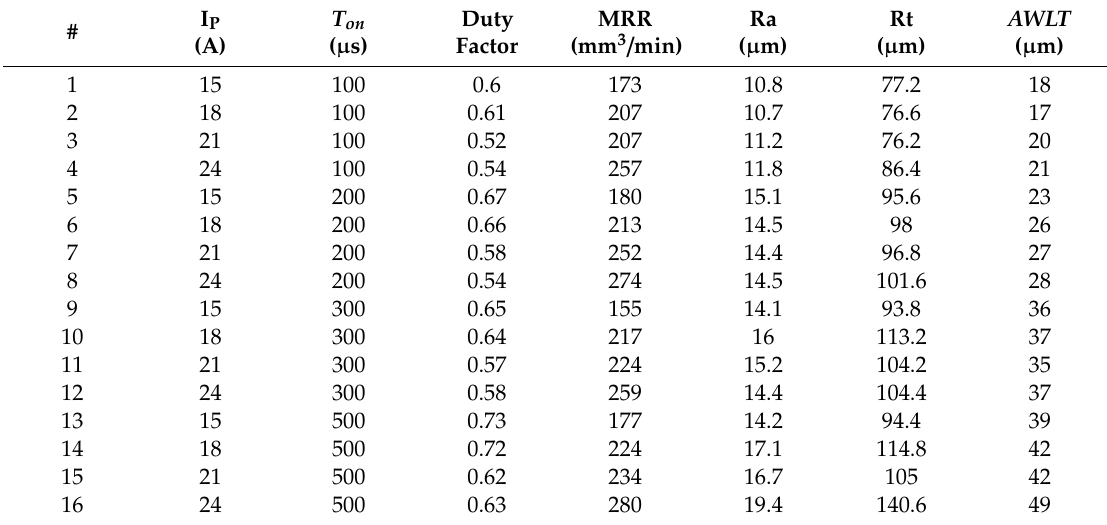
Table 2. Experimental parameters and